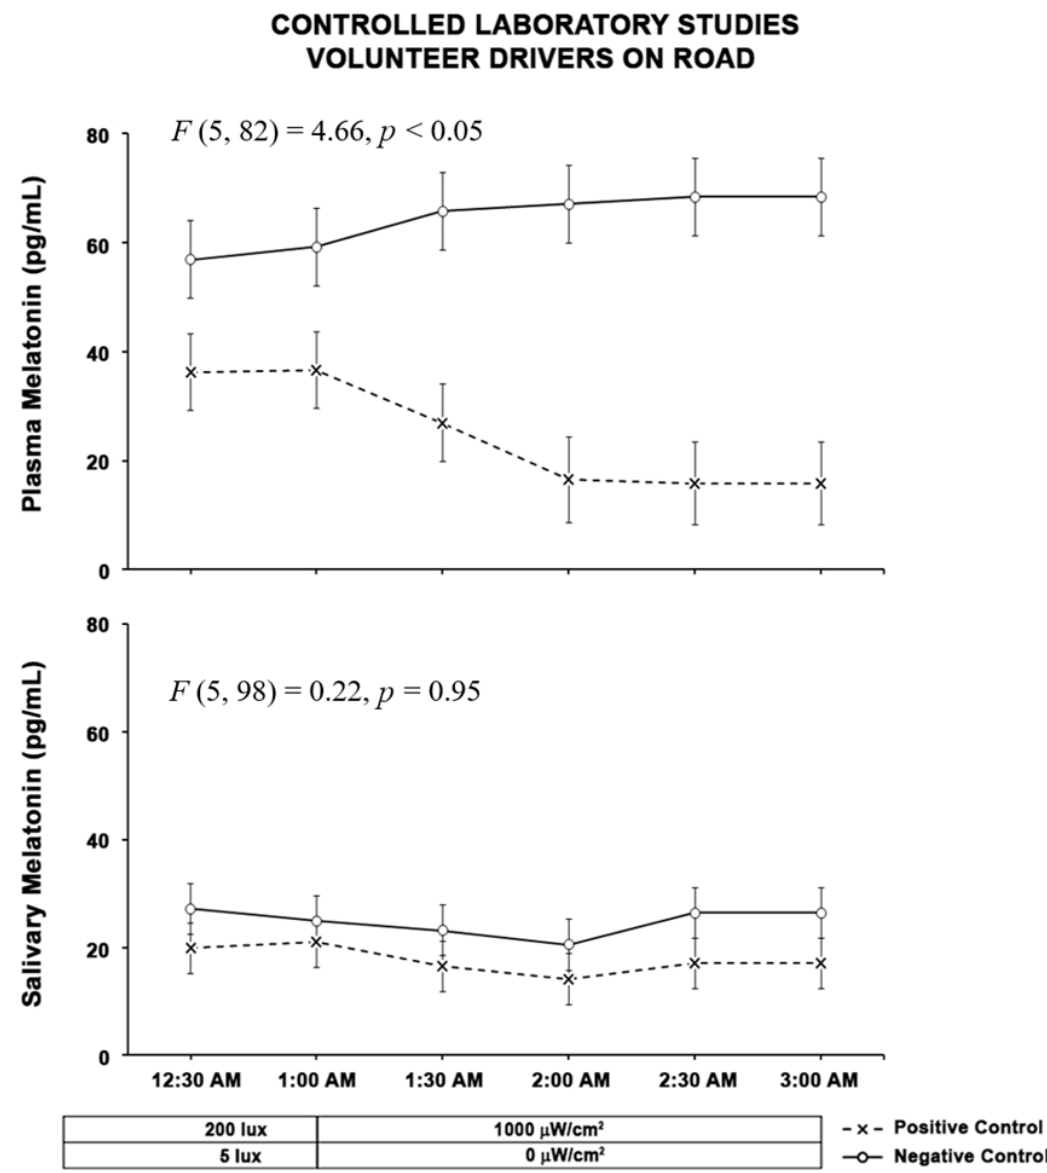
Figure 1. The two graphs above show results from subjects in the laboratory control studies. The “O” symbols represent the mean (± standard error of the mean, SEM) plasma and salivary melatonin levels during the negative control study when subjects were exposed to darkness from 1:00 AM to 3:00 AM The “X” symbols represent the mean (± SEM) plasma and salivary melatonin levels during exposure to 1000 µW/cm 2 (2132 lx Melanopic Equivalent Daylight Illuminance (EDI)) electric light from 1:00 AM to 3:00 AM Statistical comparisons of melatonin values are for the exposure periods only (1:00 AM to 3:00 AM) and are based on Linear Mixed Model analysis (LMM). For the plasma melatonin suppression, the main effect of the type of test was significant (F (1, 12.2) = 34.42, p < 0.0001) and for the salivary melatonin suppression, the main effect of the type of test was significant (F (1, 17.2) = 8.16, p = 0.01).